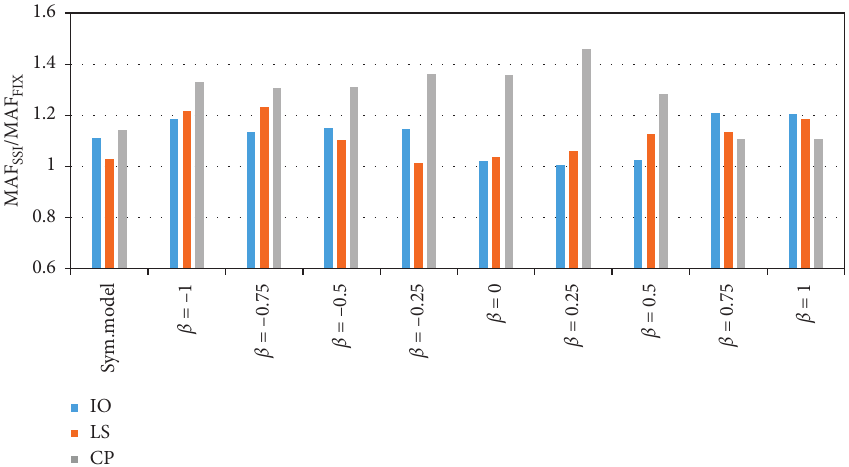
Figure 16: Comparison of the MAFs of fixed- and flexible-base